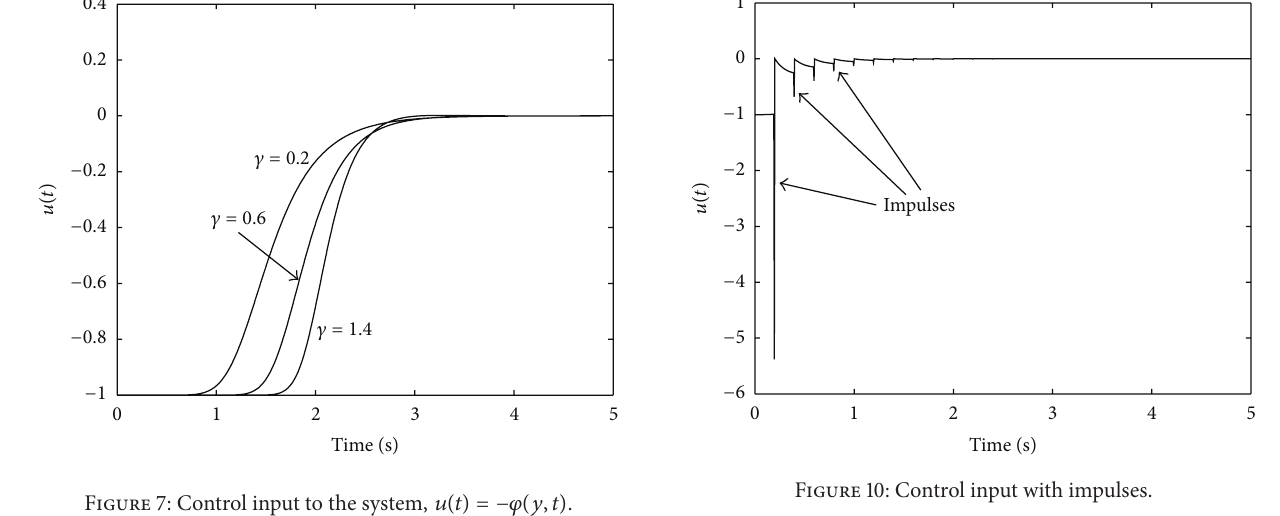
Figure 7: Control input to the system, 𝑢(𝑡) = −𝜑(𝑦,𝑡) .